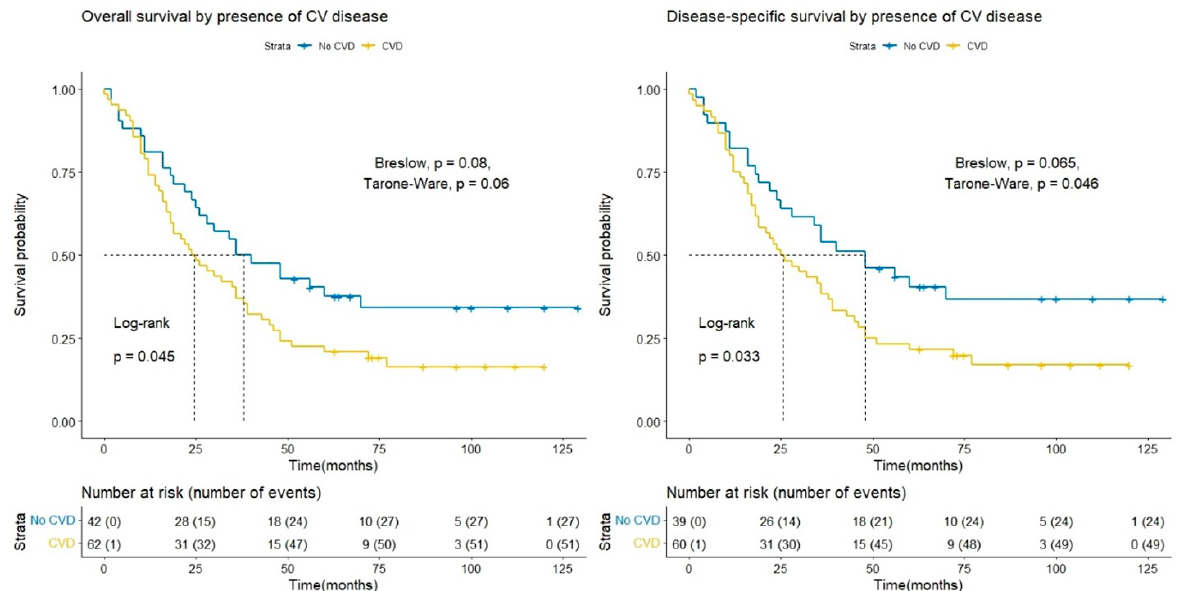
Figure 1. Comparison of CVD and Non-CVD groups in terms of overall and specific survival by Kaplan–Meier survival analysis.